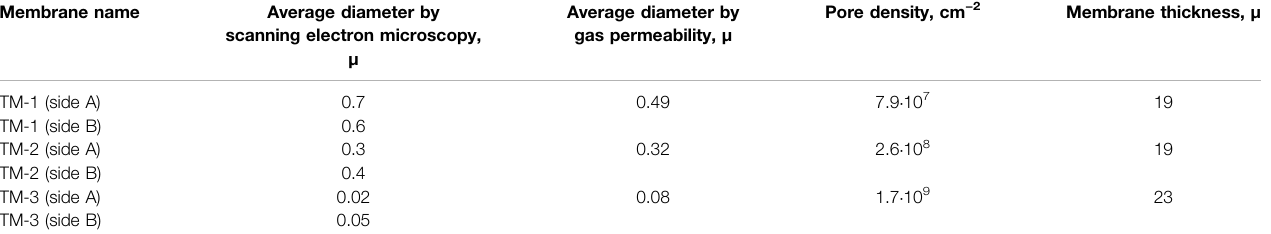
TABLE 1 | Characteristics of polyethylene terephthalate track-etched membranes with different pore sizes. Membrane name